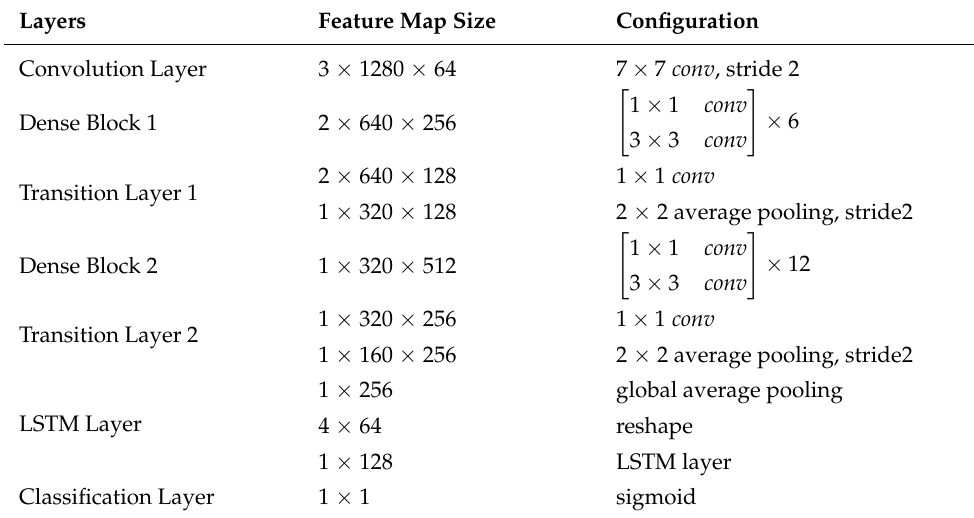
Table 1. Structure of DenseNet-LSTM.